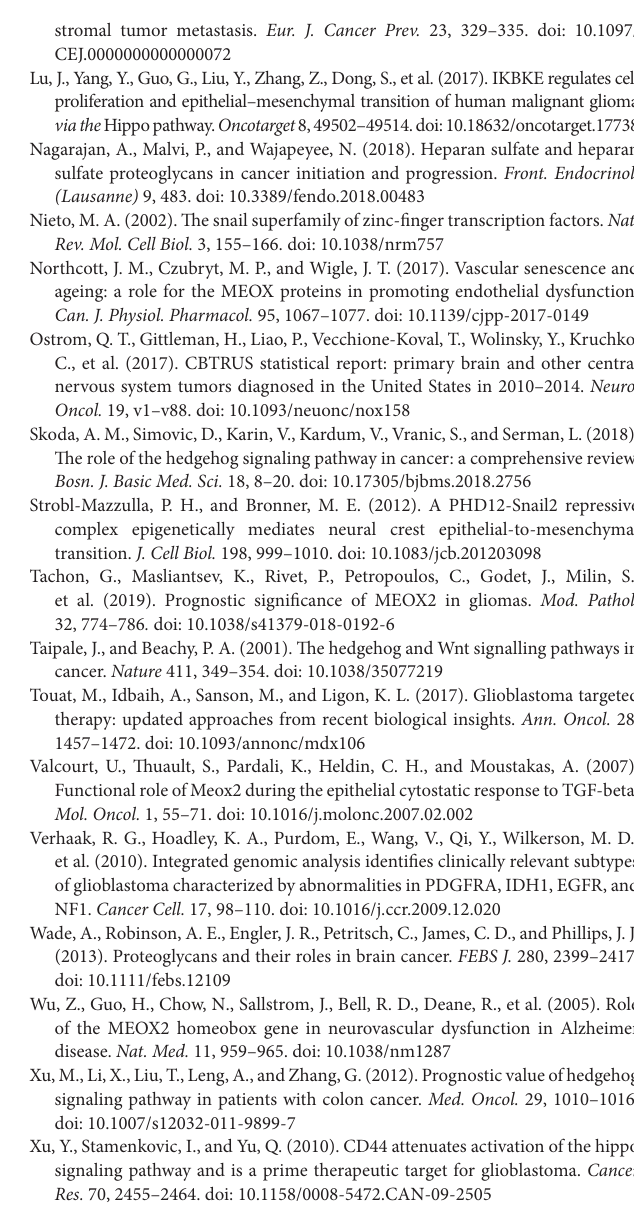
SUPPleMeNTARY FiGURe 1 | The result of the internal validation dataset 1 and 2, time-dependent receiver operating characteristic (ROC) (A , c) , kaplan- Meier curves of high-risk group and low-risk group (B , D) from the TCGA GBM array dataset. As for the external validation, time-dependent receiver operating characteristic (ROC) (e , G) , kaplan-Meier curves of high-risk group and low-risk group (F , h) of the CGGA dataset and the TCGA GBM RNA-seq dataset